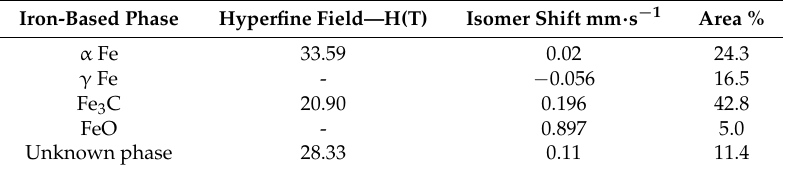
Table A1. Parameters deduced from fitting procedure of Mossbauer spectrum.